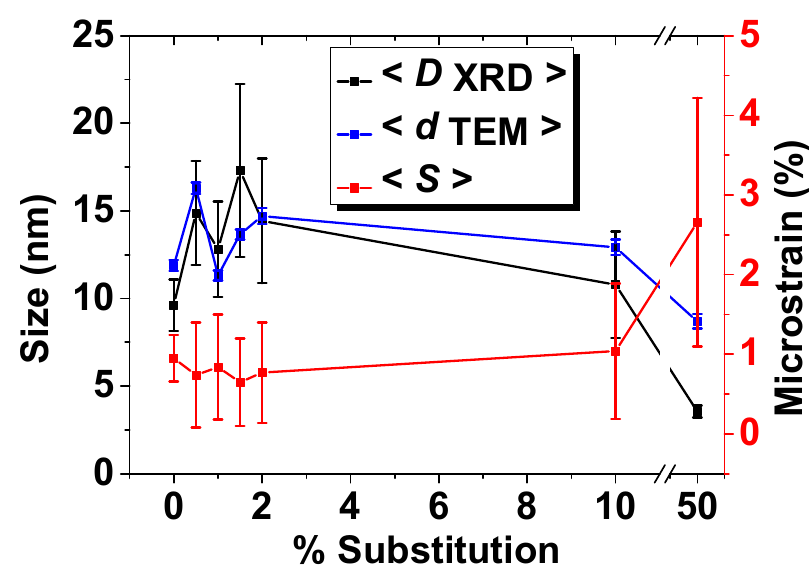
Figure 3. The estimated crystallite size, lattice microstrain and degree of crystallinity.